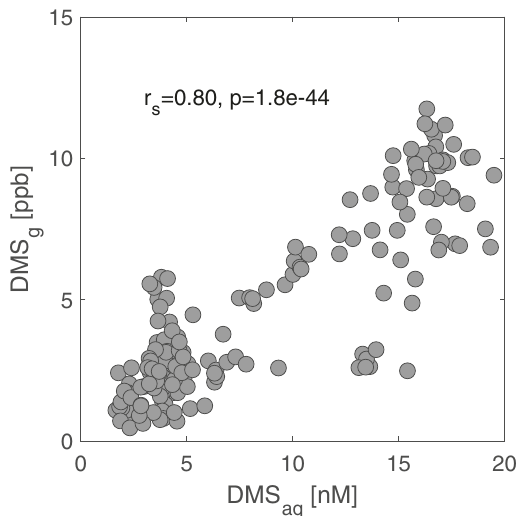
Fig. 3 The correlation between two phases of dimethyl sul fi de (DMS) in seawater (DMS aq ) and air (DMS g ). Measurements ( n = 193) of both phases were highly correlated over 5 days of sampling off the coast of Cape Cod, MA,